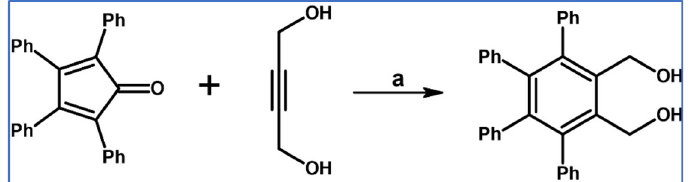
Scheme 6. DA cycloaddition with CO extrusion: synthesis of tetraphenylbenzenecarboxylic acid from tetraphenylcyclopentadienone and propynoic acid [62]. Reagents and conditions: a = bromo- benzene, rfx, 8 h,Y = 62%. In 1958, a kinetic study of DA cycloaddition with CO extrusion using substituted methyl phenylpropiolate and tetraphenylcyclopentadienone as dienophile and diene, re- spectively, were presented (Scheme 7) [63]. Scheme 7. DA cycloaddition with CO extrusion. a = kinetic studies. It has been shown that it is a second order reaction, that electron withdrawing sub- stituents increase the reaction rate, the activation energy for R = o -Cl and p -Cl are almost identical, and activation entropy for aforementioned substituents is strongly negative and nearly the same. Ogliaruso and co-workers described DA cycloaddition between appropriate bis-cy- clopentadienones and diphenylacetylene leading to bis(pentaphenyl)benzenes, in which two mirror fragments are connected with –CH 2 –, – O – or – S – linkers (Scheme 8) [64]. Scheme 8. DA cycloaddition of bis-cyclopentadienones and diphenylacetylene: synthesis of bis[(pentaphenyl)benzenes] [64]. Reagents and conditions: X = nil, CH 2 , O or S ; a = heating up to 260 °C, up to 1 h (it depends on the linker structure), up to 81%